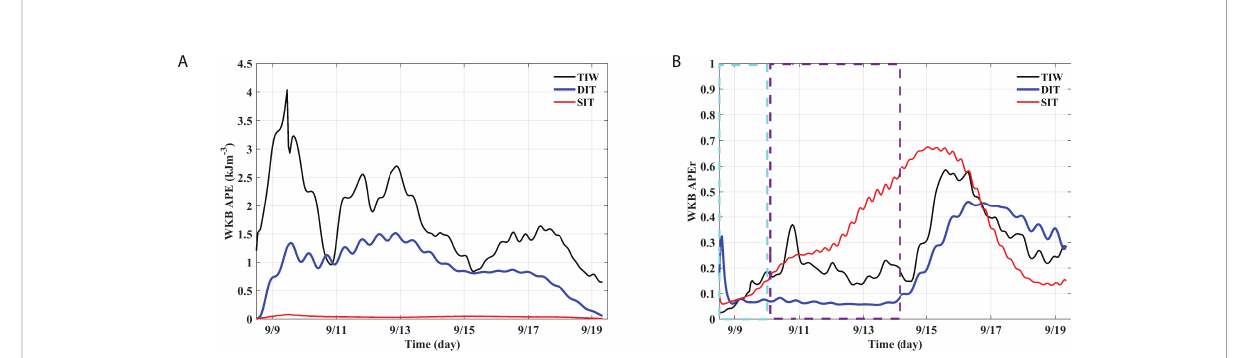
FIGURE 6 The available depth-integrated APEs are shown. (A) APEs of total internal waves (TIW), DIT, and SIT are shown for the entire glider observation period. (B) APE ratios ( APEr ) of the upper layer to the entire water column are plotted during the same period. A cyan broken-line box denotes the pre-VM interval during which the glider moves in a zig-zag manner to a target station, and the purple box denotes the eddy center (target) under VM